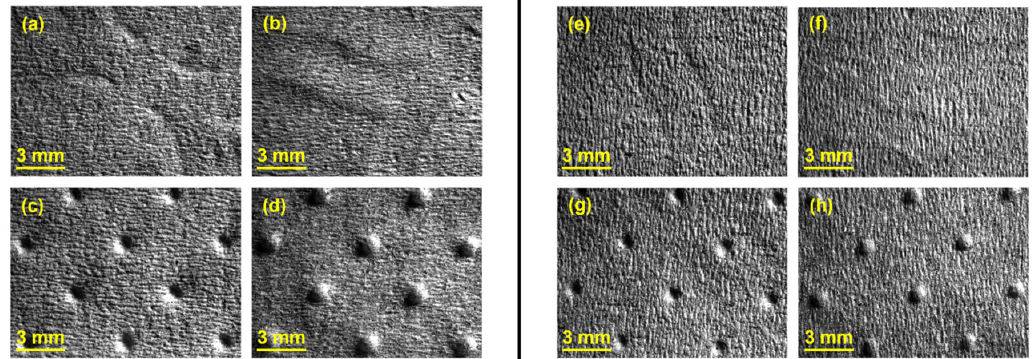
Figure 10. Global views of tissue paper embossed with the different combinations of rubber hardness of configuration 2: ( a ) 60_48 Sh-A (deco—front side); ( b ) 60_48 Sh-A (deco—back side); ( c ) 60_48 Sh-A (micro—front side); ( d ) 60_48 Sh-A (micro—back side); ( e ) 75_48 Sh-A (deco—front side); ( f ) 75_48 Sh-A (deco—back side); ( g ) 75_48 Sh-A (micro—front side); and ( h ) 75_48 Sh-A (micro—back side).